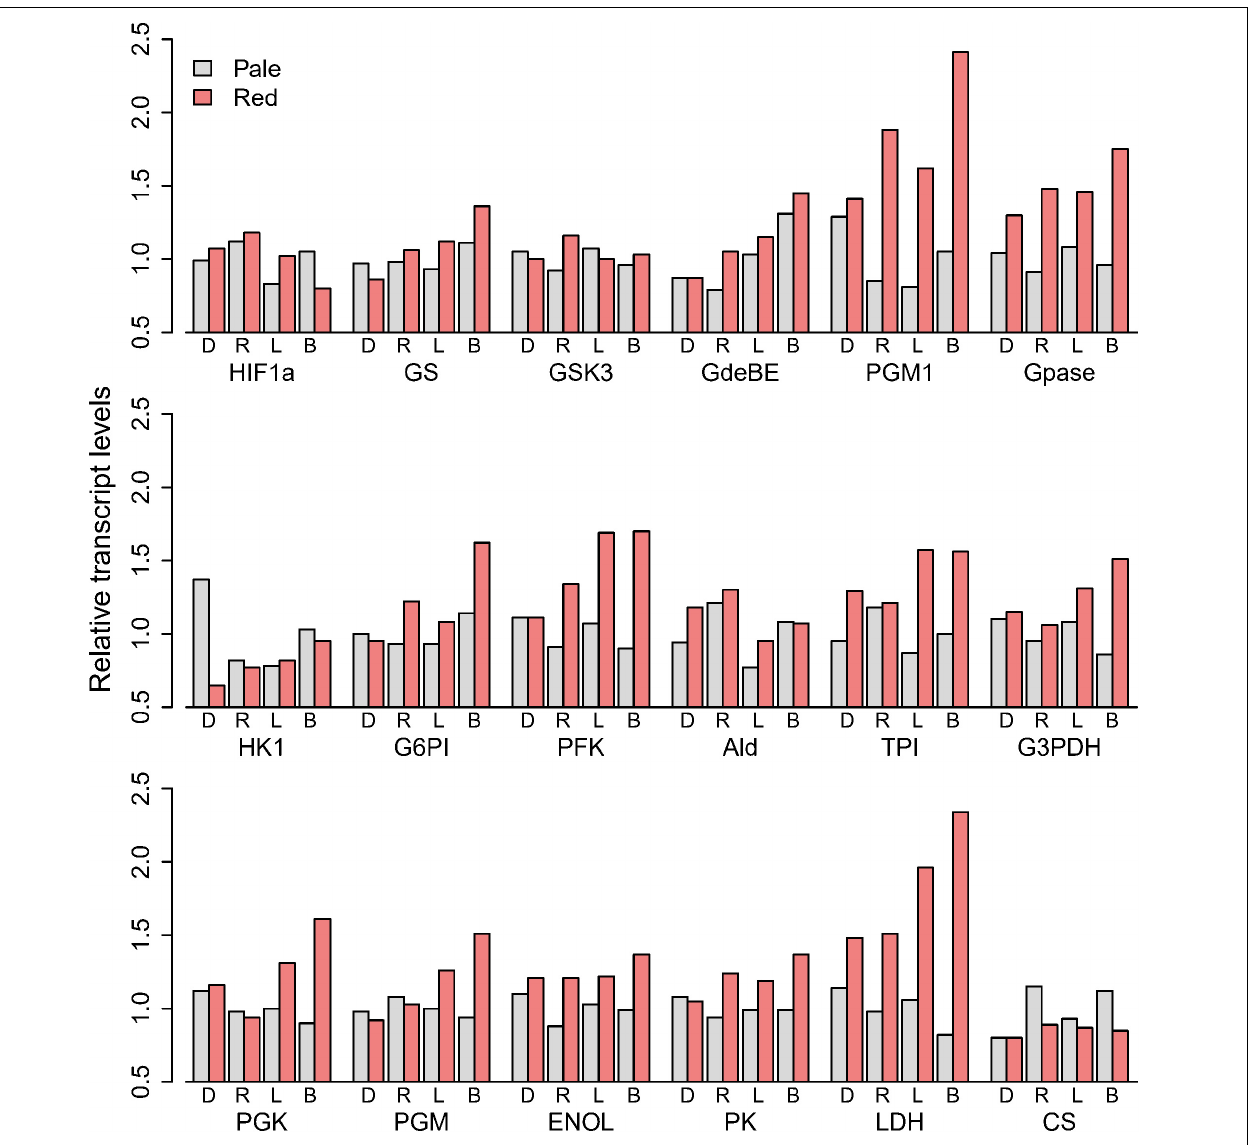
FIGURE 4 | Transcript levels of glycolytic enzymes of pale and red D. pulicaria , relative to the mean of the pale animals from the four hypoxic lakes: Doe Lake (D) Round Lake (R), Long Lake (L), and Black Lake (B).